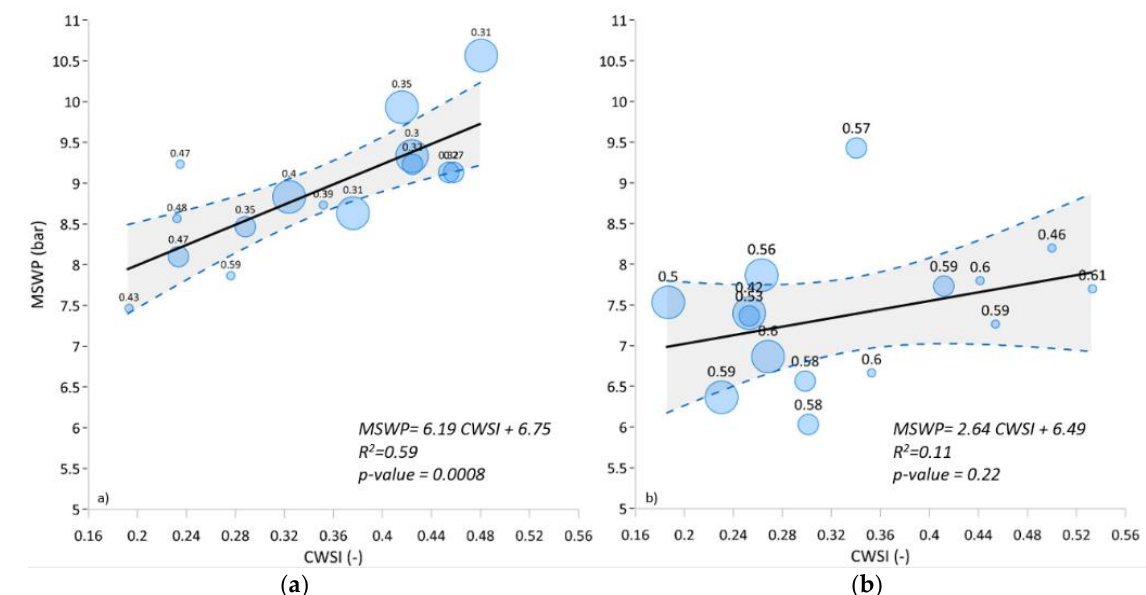
Figure 12. Relationship between CWSI vs. MSWP for Montevertine ( a ) and San Giusto a Rentennano ( b ). The size of the bubble is proportional to the slope gradient, whereas the number next to the bubble indicates the NDVI value.